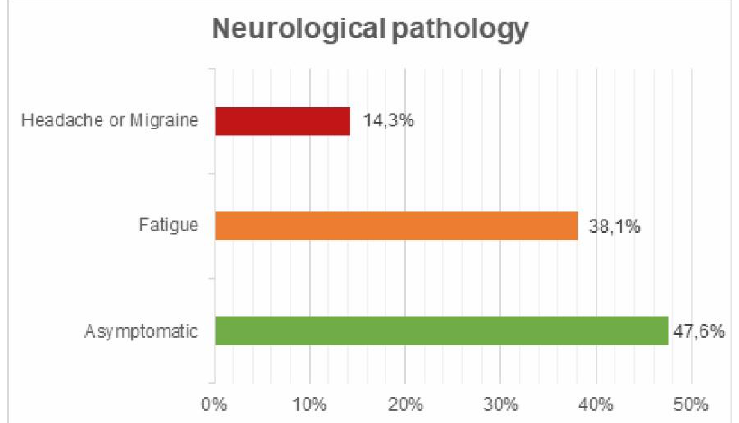
Figure 12. Neurological pathology survey.